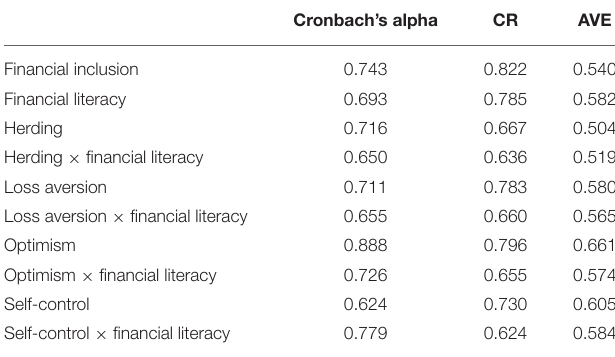
TABLE 2 | Construct reliability and validity.